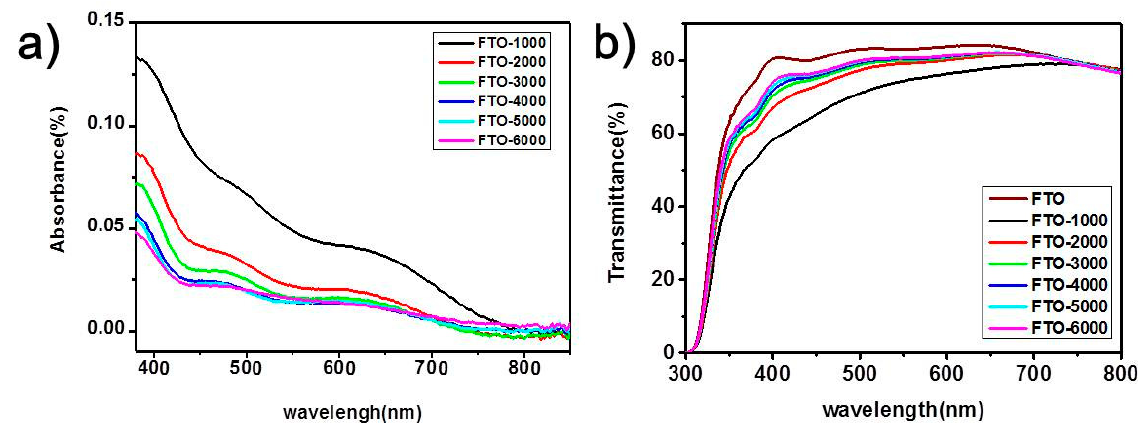
Figure 5. ( a ) Absorption spectra of the CIGS thin films at different spin-coating speeds. ( b ) Optical transmittance spectra of the pristine FTO and CIGS thin films at different spin-coating speeds.